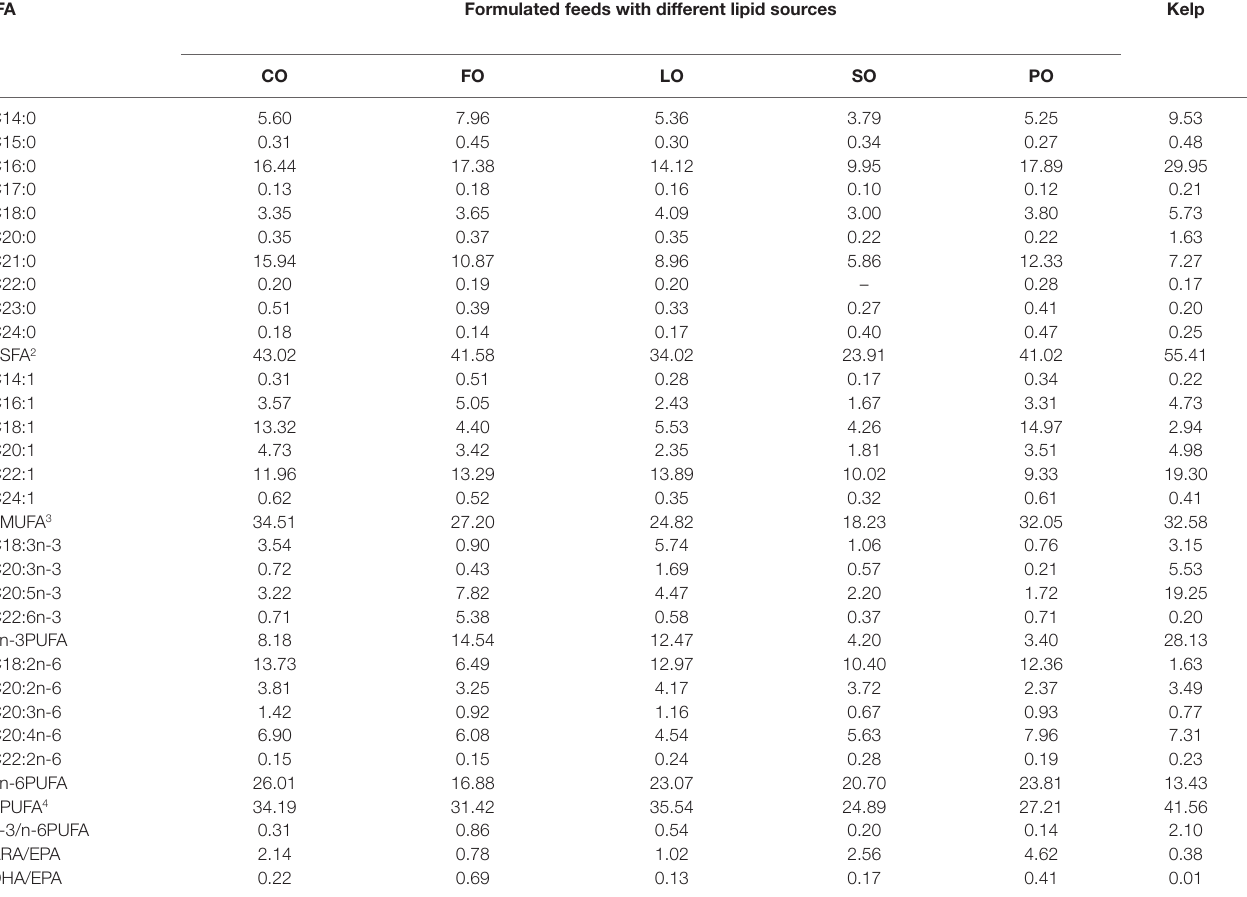
TABLE 10 | Effects of different lipid sources on the fatty acid composition (g/kg dry matter) in the prismatic larvae of sea urchin ( Strongylocentrotus intermedius ) (n=1) 1 . FA Formulated feeds with different lipid sources Kelp